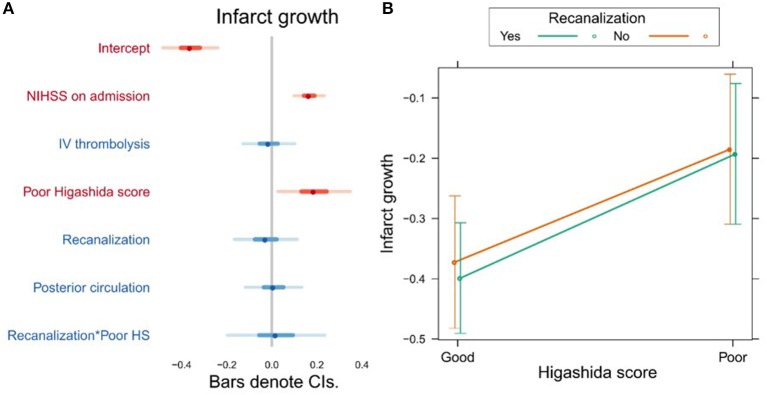
(A) Association between several variables and infarct growth. The dots indicate the beta coefficients derived from a robust multiple linear regression. Bars indicate the 95% confidence intervals (CI) of the estimates. Independent variables shown in red have statistically significant coefficients (p < 0.05). (B) Plot showing the predicted infarct growth values for recanalizers and non-recanalizers with good and poor Higashida scores. The plot shows that good collateral flow is associated with less infarct growth, but there is no significant association between recanalization and infarct growth. In addition, the association between collateral flow and infarct growth is similar across patients, whether or not they recanalized.